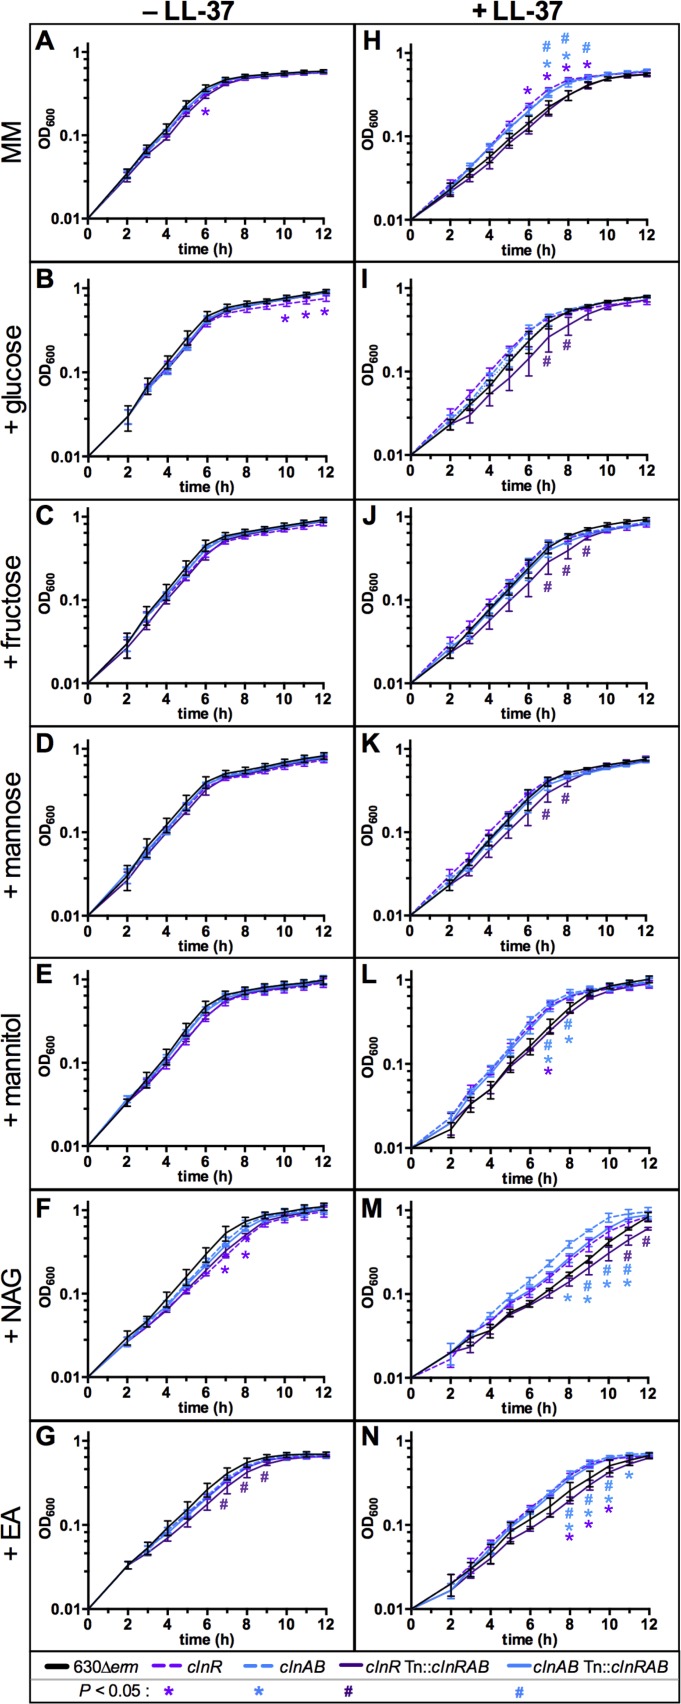
ClnR and LL-37 regulate the metabolism of nutrients.Active cultures of strain 630Δerm (black), the clnR mutant (MC885, light purple), the clnAB mutant (MC935, light blue), clnR Tn::clnRAB (MC950, dark purple), and clnAB Tn::clnRAB (MC953, dark blue) were diluted to an OD600 in 0.01 in minimal media (MM) either without (A-G) or with (H-N) 0.5 μg/ml LL-37. Base minimal media (A, H) or MM supplemented with 30 mM glucose (B, I), 30 mM fructose (C, J), 30 mM mannose (D, K), 30 mM mannitol (E, L), 30 mM N-acetylglucoseamine (NAG) (F, M), or 30 mM ethanolamine (EA) (G, N). Graphs are plotted as the means +/- SEM from three independent replicates. Data were analyzed by two-way ANOVA with Dunnett’s multiple comparison test, comparing to 630Δerm at each time point. Adjusted p value < 0.05 indicated by the symbols in the legend.